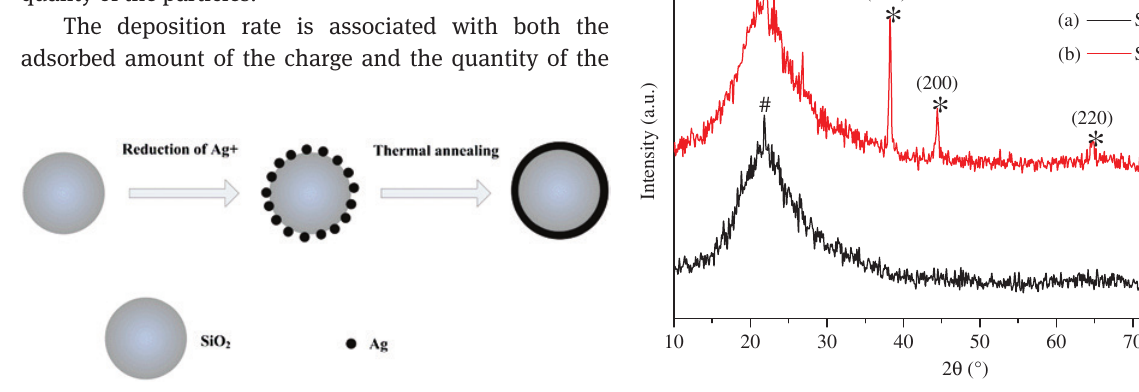
Figure 2: (a) XRD patterns of bare silica powder; (b) SiO posite spheres prepared by pulse